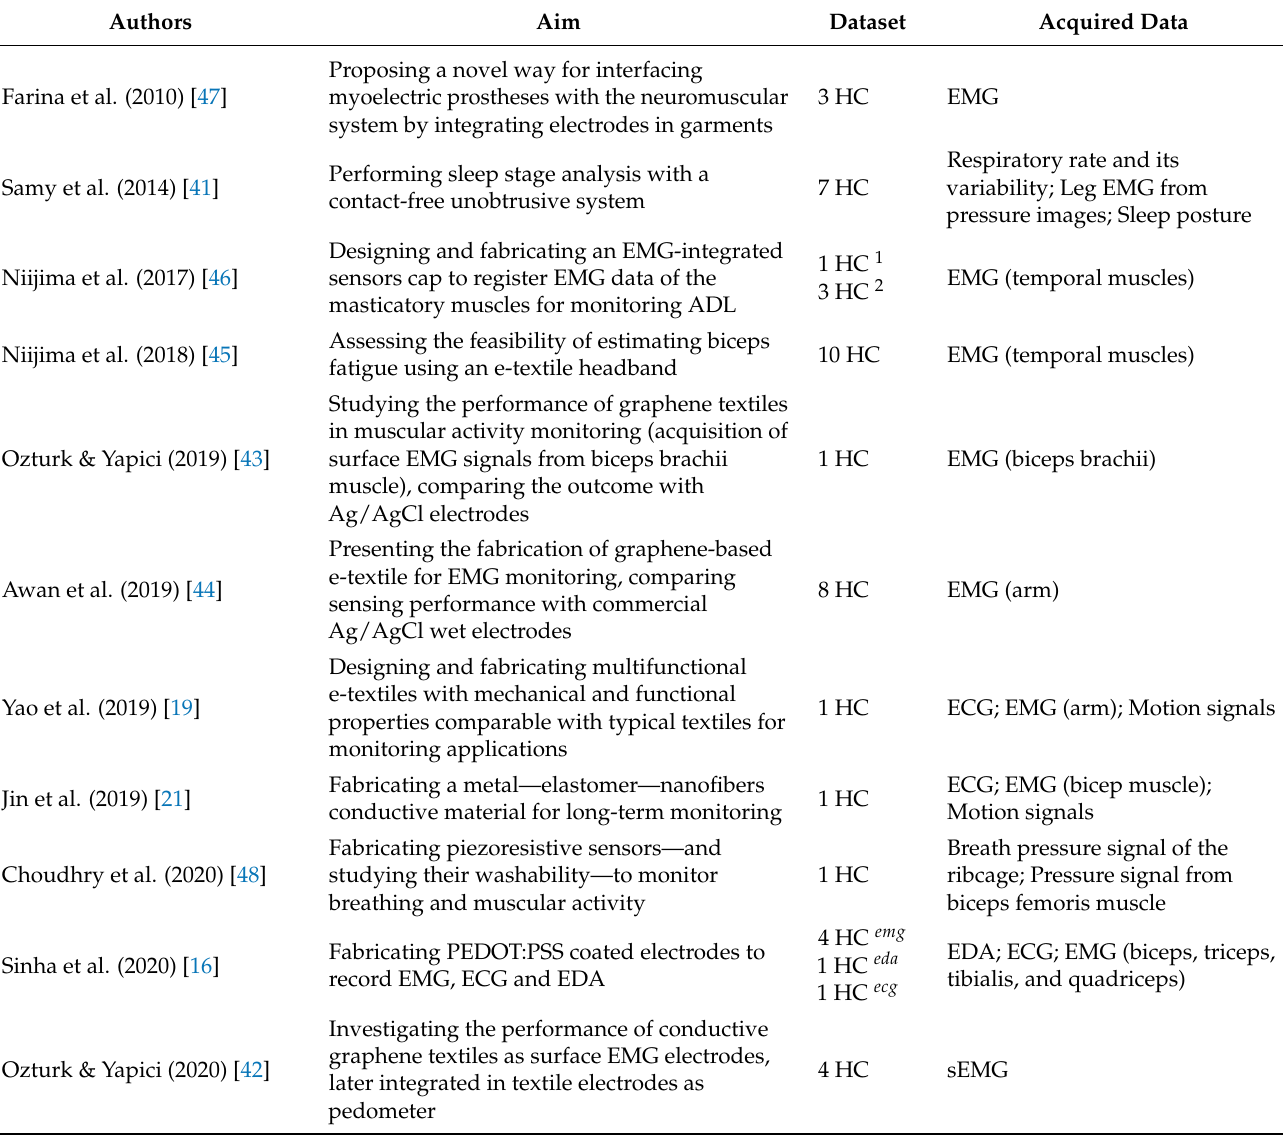
Table 3. Insights regarding literature in muscular setting: authors, aim, dataset, and acquired